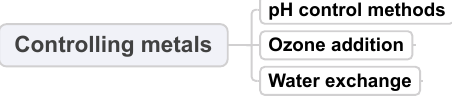
Figure 8. Taxonomy: controlling